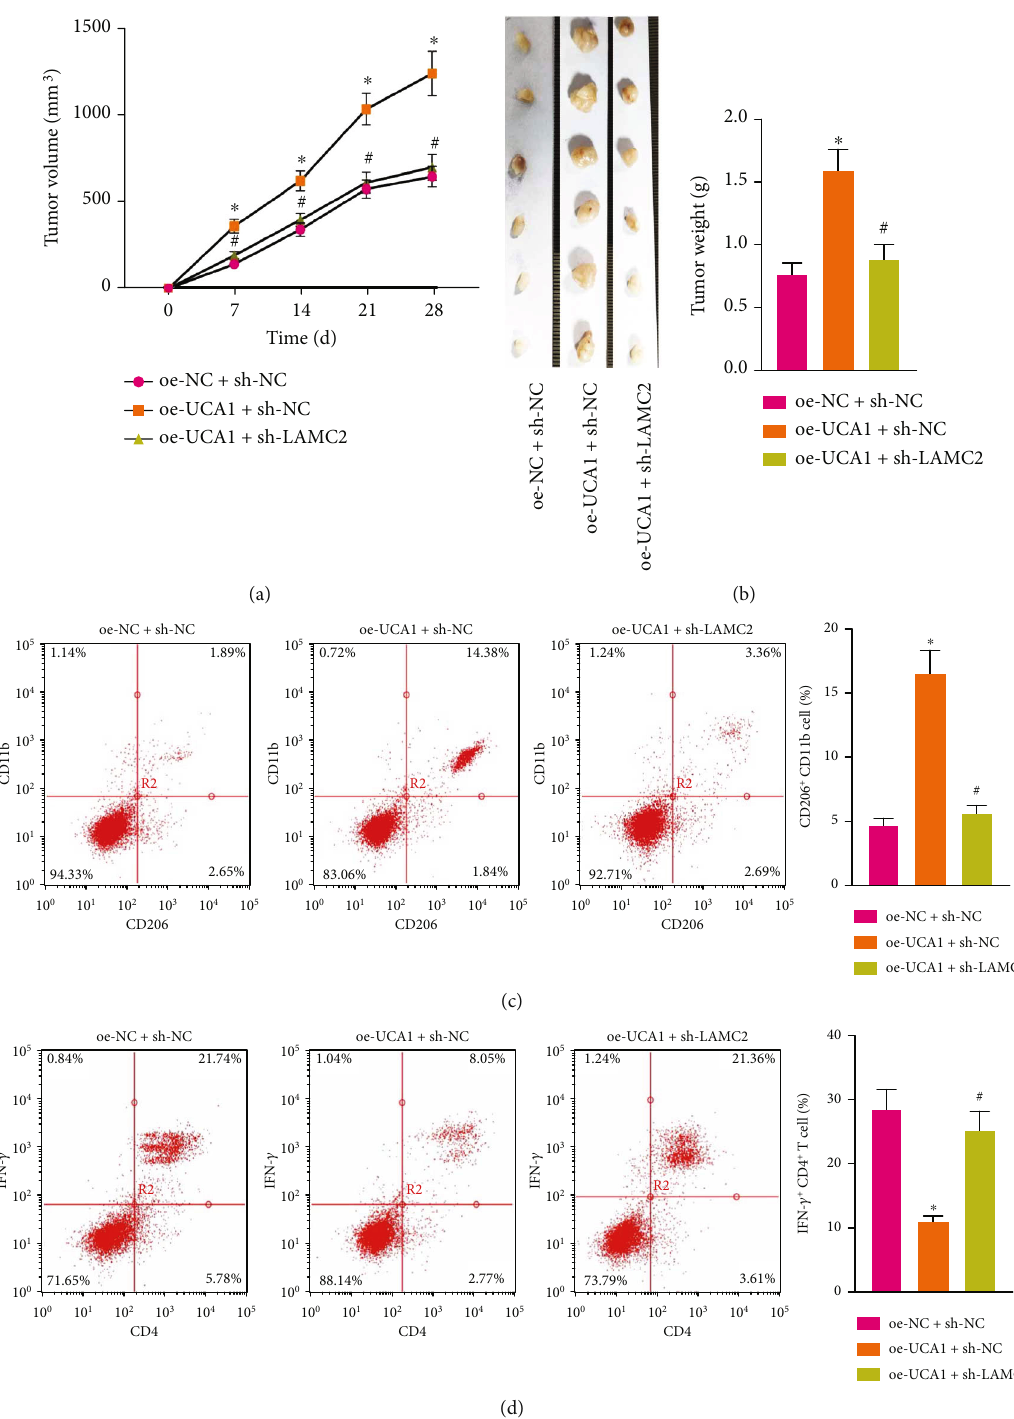
Figure 5: OSCC-CSC-derived sEVs transferring UCA1 accelerate M2 macrophage polarization and enhance the tumorigenicity of OSCC xenografts in nude mice. (a) Tumor volume curve and (b) tumor weight of nude mice ( n = 6 ) in di ff erent treatment groups. (c) Detection of CD206 + CD11b + M2 macrophages in the tumor tissues of nude mice, determined by fl ow cytometry in di ff erent treatment groups. (d) Detection of IFN- γ + CD4 + T cells among the spleen cells in nude mice, determined by fl ow cytometry in di ff erent treatment groups. ∗ p < 0 : 05 , # p > 0 : 05 . The data in the fi gure were measurement data from 6 mice, which summarized as mean ± standard deviation treatment, the tumor volume (Figure 5(a)) and tumor weight Flow cytometry indicated that the proportion of CD (Figure 5(b)) in mice had clearly increased, but this e ff ect 206 + CD11b + cells (Figure 5(c)) increased and that of IFN- γ + CD4 + T cells (Figure 5(d)) decreased signi fi cantly after was abrogated by sh-LAMC2.